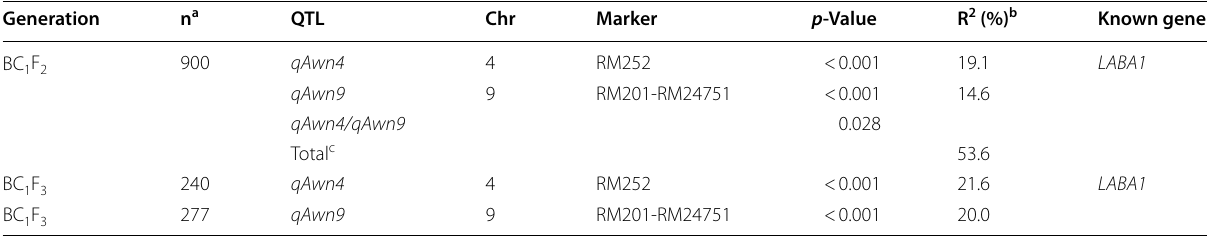
F and BC F 1 2 1 3